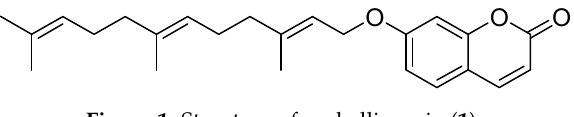
Figure 1. Structure of umbelliprenin ( 1 )